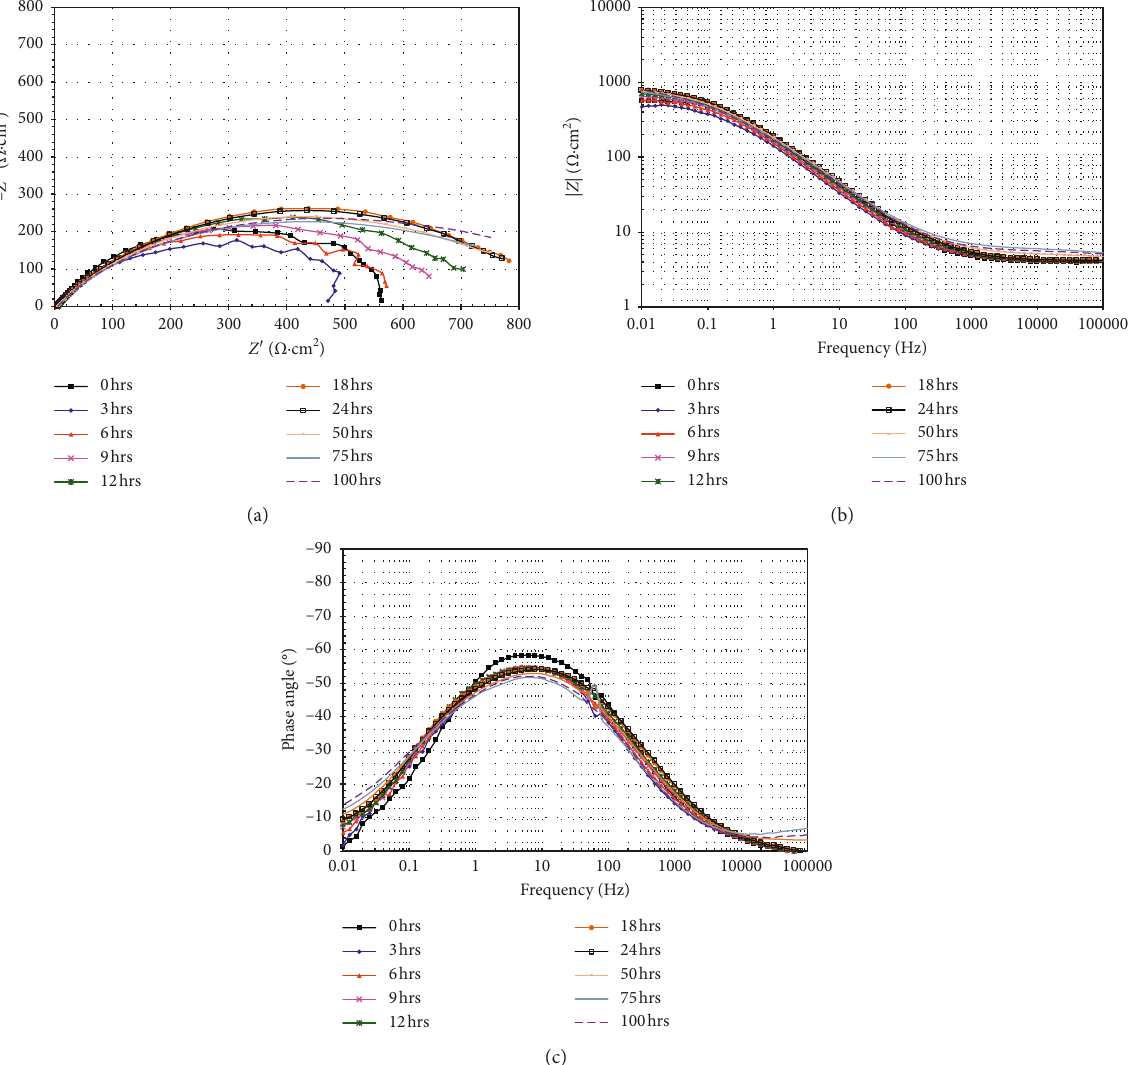
Figure 13: Evolution of Nyquist and Bode diagrams for API X70 steel in 3.5% NaCl solution without inhibitor